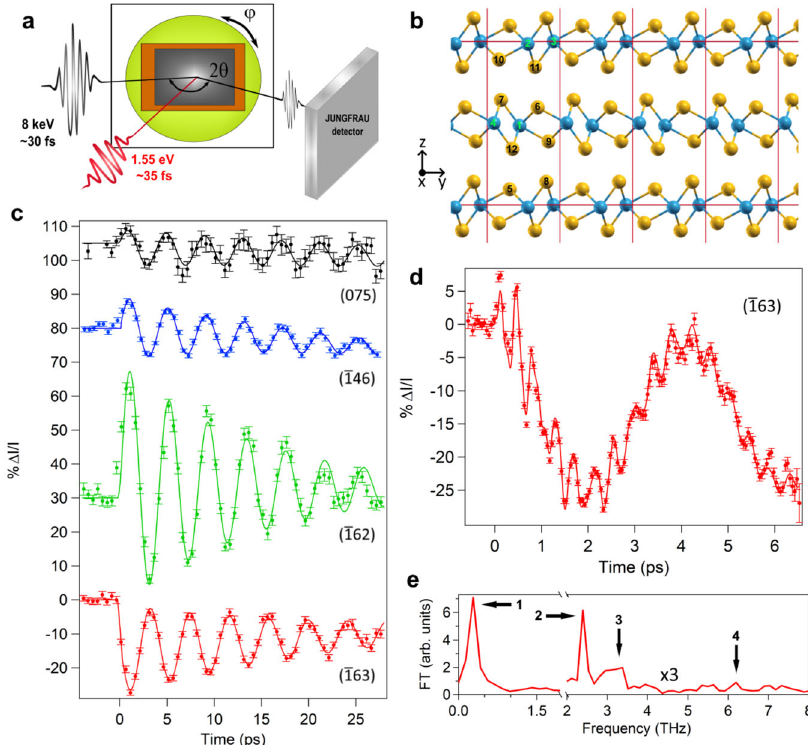
Fig. 1 Experiment scheme and TRXD results. a Scheme of the time-resolved X-ray diffraction experiment. b WTe 2 crystal structure projected in the yz plane where the red rectangles delimit the orthorhombic unit cell; the atomic labels are used for discussion in the text. c Time- resolved modi fi cation of the diffraction intensity Δ I / I for the (075), ð 146 Þ , ð 162 Þ , and ð 163 Þ diffraction peaks, where the traces are shifted for visualization purposes, and d for the ð 163 Þ re fl ection using a tenfold shorter time step; in the latter panel, the fi t model takes into account four oscillatory contributions (see text). In the graphs, the markers correspond to experimental data, while the continuous lines are the fi t curves. e Fourier transform of panel d after subtracting the non-oscillatory response; the right part of the curve multiplied was by 3 to highlight the peaks indicated by the black arrows. The data were acquired at 3.2 mJ/cm 2 absorbed fl uence at T = 295 K. The error bars represent one standard deviation